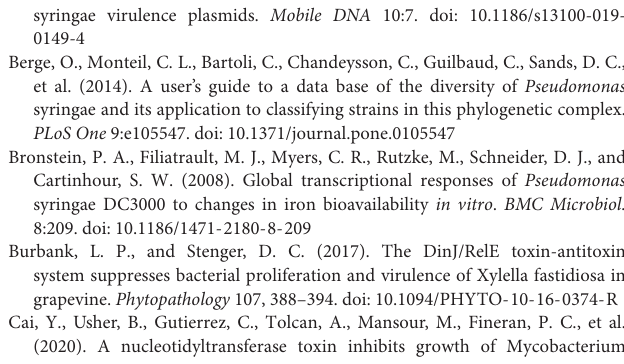
Supplementary Table 3 | Data on transcriptomics study analyzed for TA systems in this